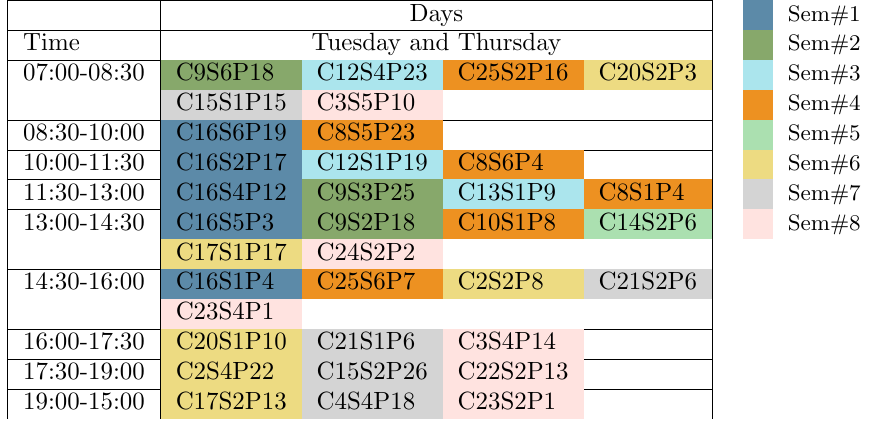
Figure 2. Timetable for courses in day scheme B: Tuesday and Thursday, two classes of 1 h and a half per